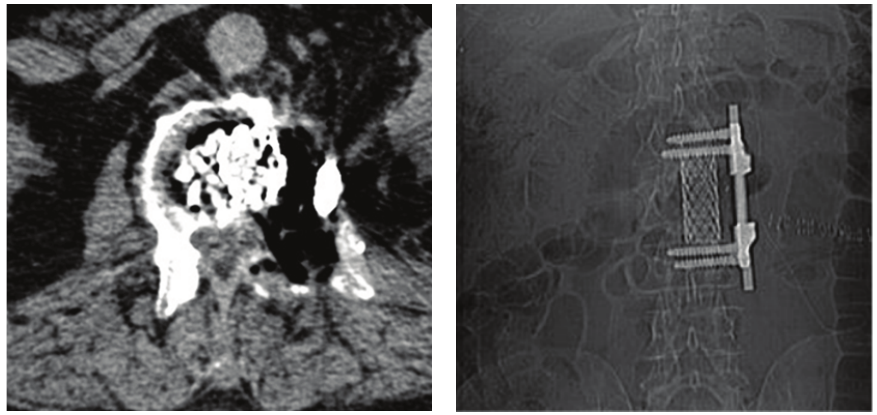
Figure 2: Postoperative CT scan demonstrating the tumor removal and the anterior column reconstruction.